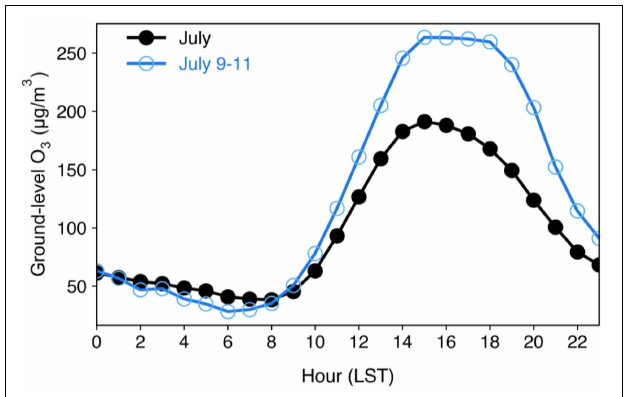
FIGURE 9 | Diurnal pattern of ground-level O 3 concentrations observed from CNEMC network in